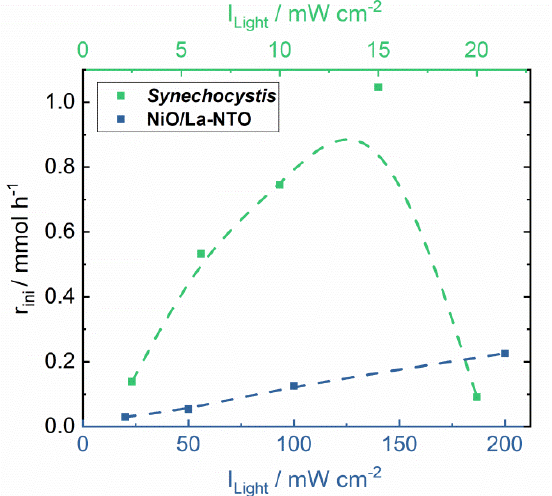
Figure 3. Initial O 2 evolution rate of Synechocystis (green) and initial H 2 evolution rate of NiO/La- NTO (blue) under full light spectrum (without a light filter) using a cell concentration of 0.163 g dm −3 (OD 750 = 1) for the bacteria cells and a photocatalyst concentration of 1 g dm −3 for the semicon- ductor.